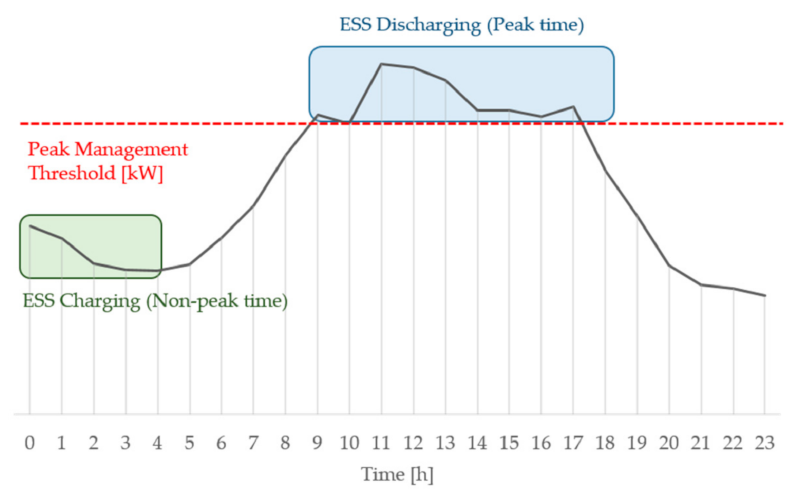
Figure 3. Outline of ESS peak reduction operation.